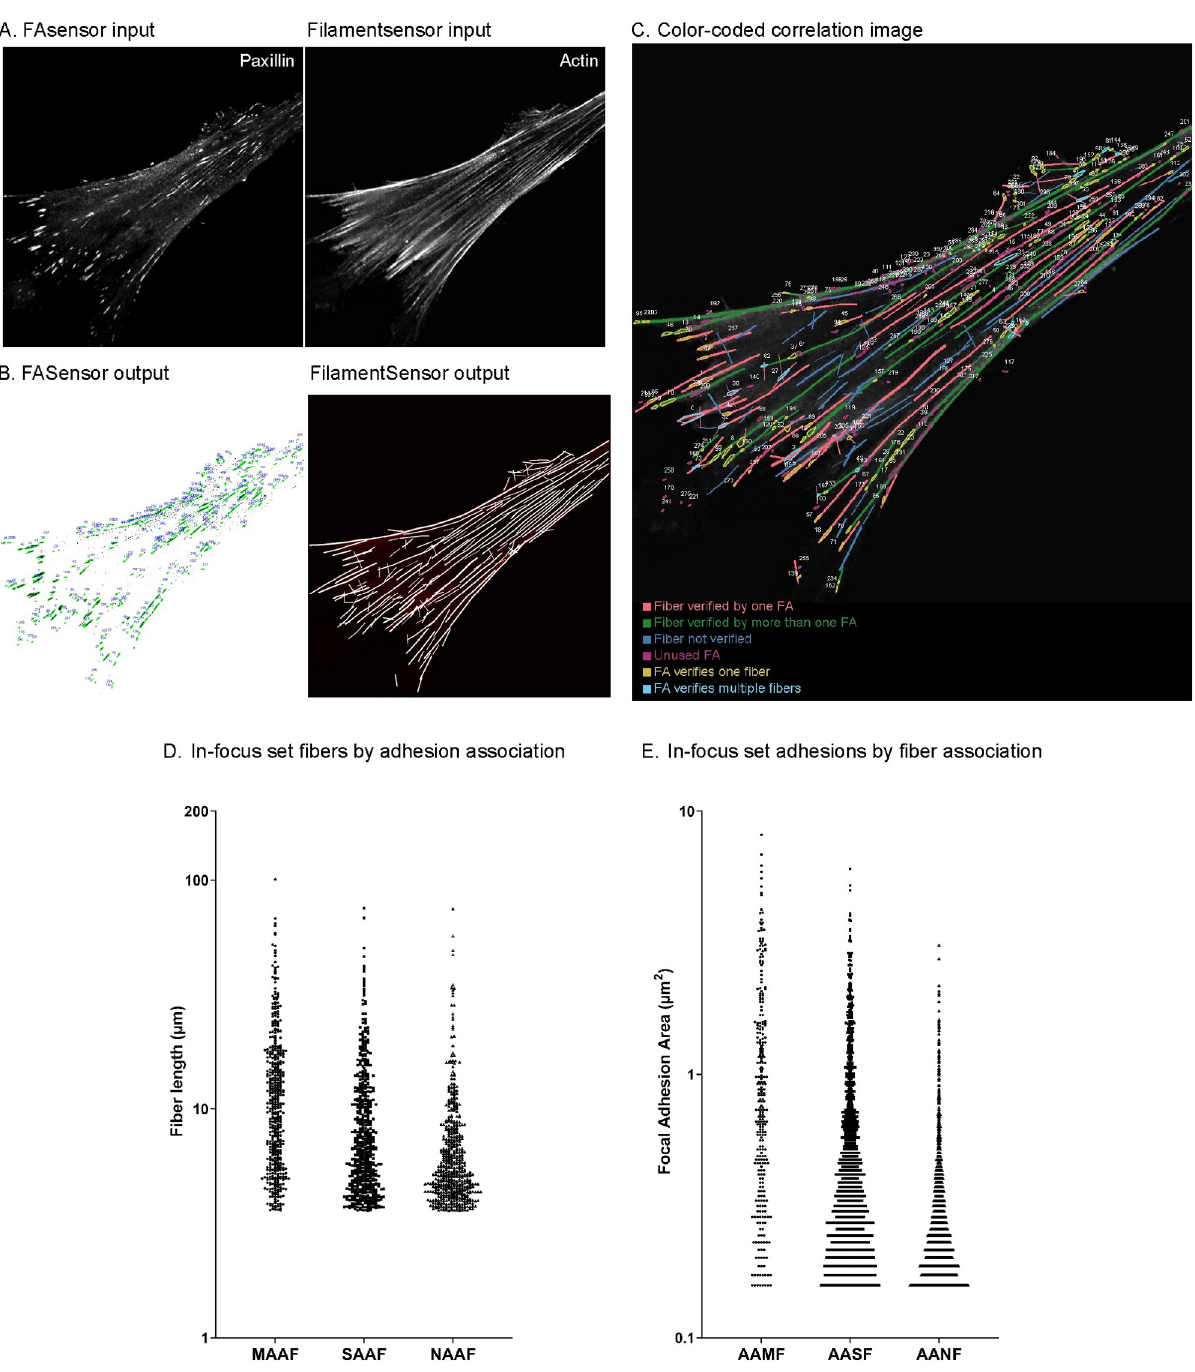
Fig 8. Correlation of focal adhesions and actin filaments by FAFCK. A) Input images of the ventral plane of a MRC5 cell (left) adhesions (paxillin) and (right) actin filaments (phalloidin). B) Map of numbered adhesion objects detected by FASensor (left), map of filaments detected by FilamentSensor (right). C) Color coded map of correlated adhesions and filaments categorized by association (legend in image). D) Aggregate graph of lengths of filaments categorized by adhesion association in all cells of the in-focus dataset. Y axis is in logarithmic scale. MAAF- Multiple adhesion associated filament, SAAF—Single adhesion associated filament and NAAF—Not adhesion associated filament. E) Aggregate graph of areas of adhesions categorized by filament association in all cells of in-focus dataset. Y axis is in logarithmic scale. AAMF—Adhesion associated with multiple fibers, AASF—Adhesion associated with single fiber and AANF—Adhesion associated with no fibers.